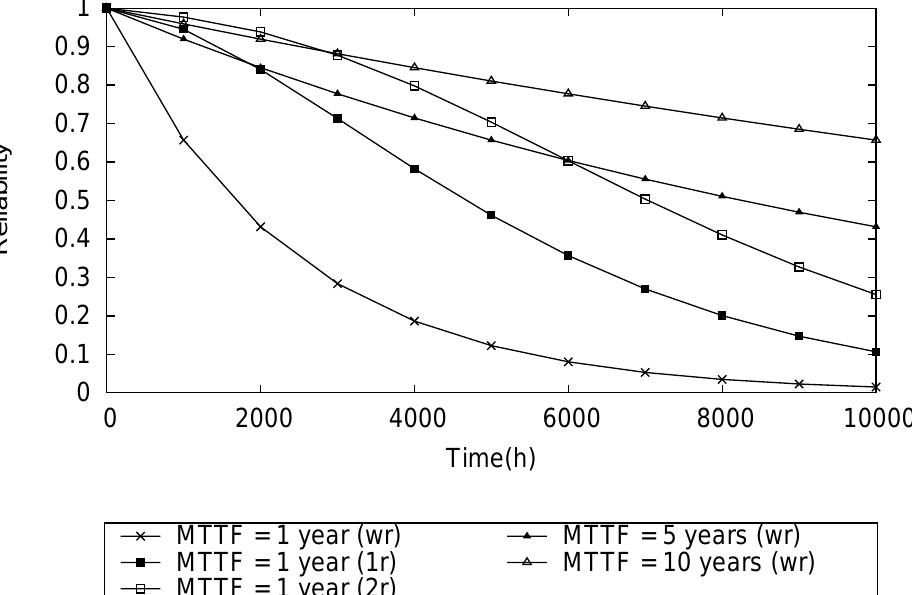
Figure 15. Reliability evaluation for a star